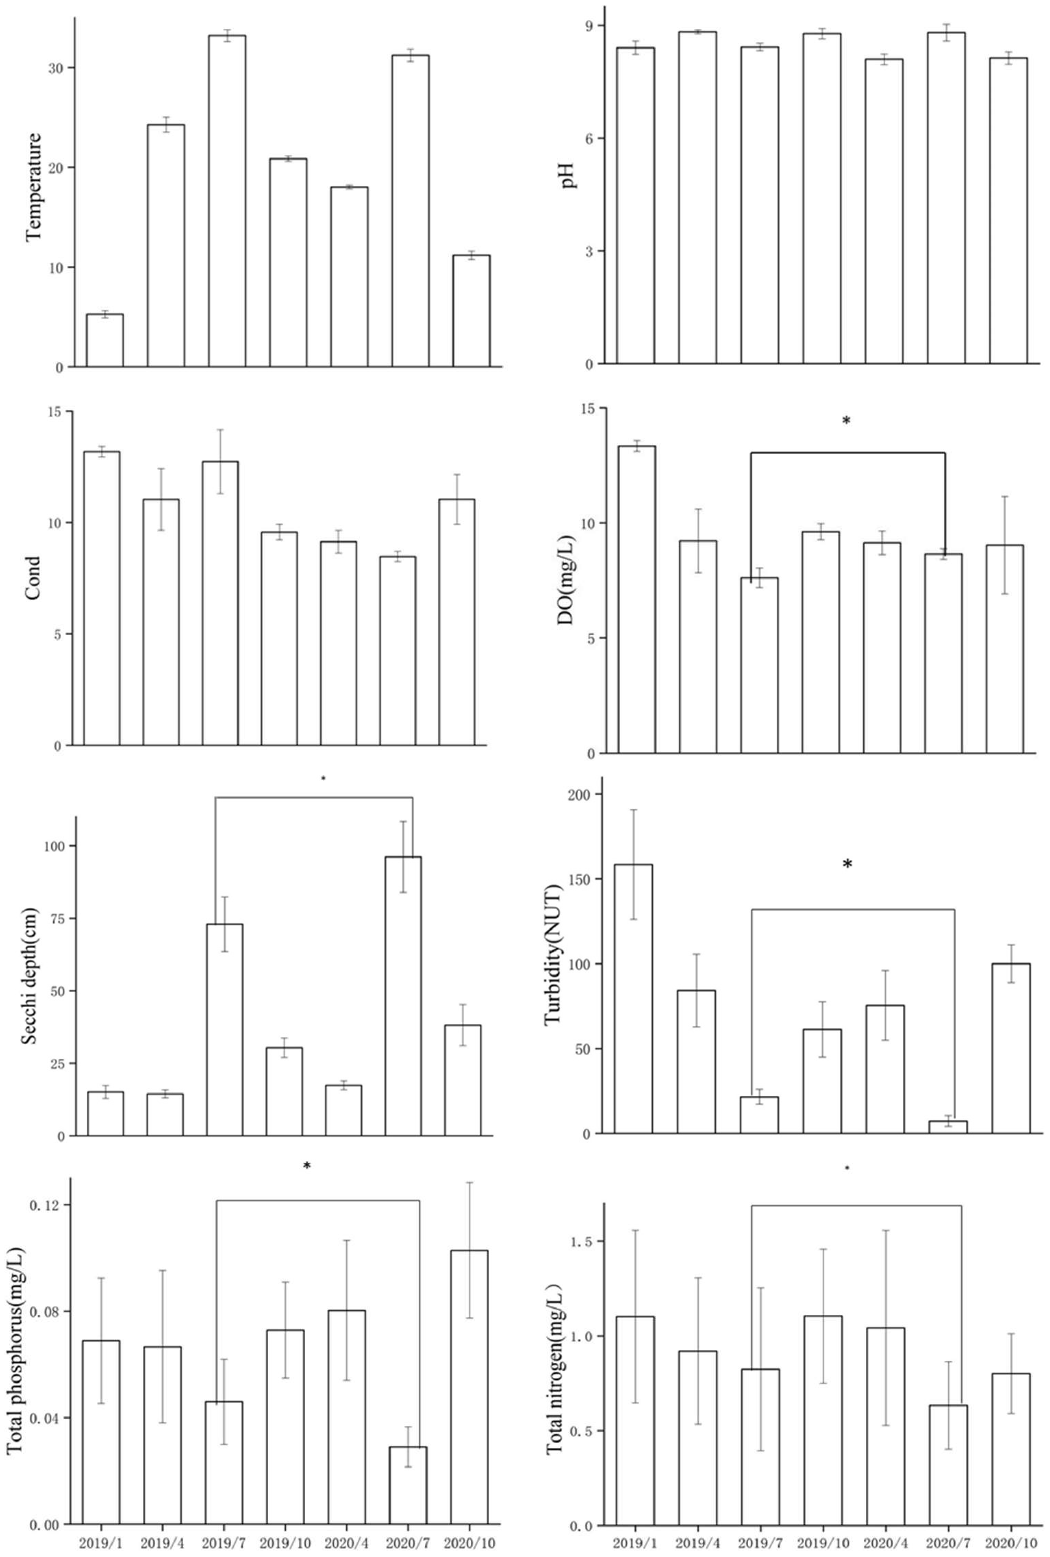
Figure 3. The characteristics of environmental factors before and after the flooding of Huayanghe River. Abbreviations used in the diagram: Cond: conductivity, DO: dissolved oxygen (flooding occurred in July 2020) (* p < 0.05).